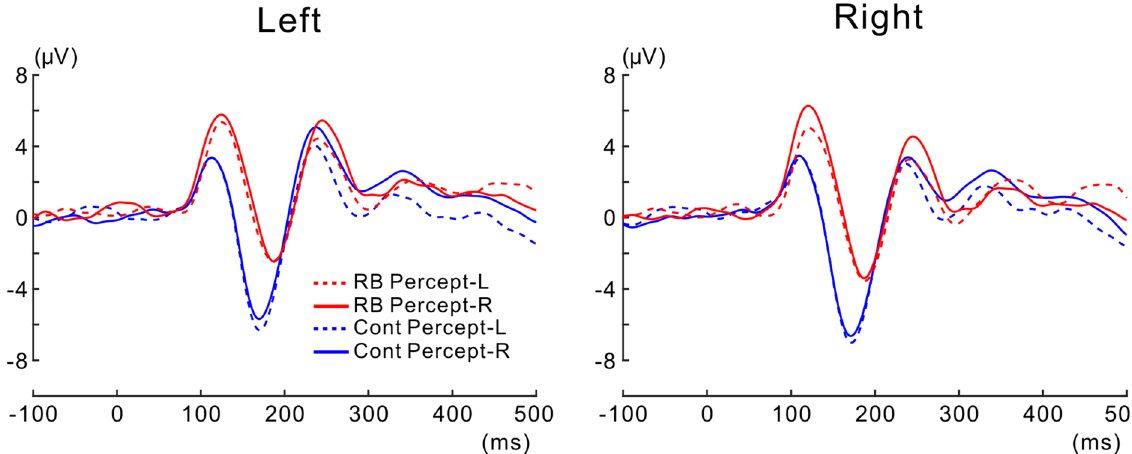
Figure 6. VEPs sorted with each percept for the Necker lattice. Grand-averaged VEPs calculated with trials where the Necker lattice was perceived as an upper-left-facing lattice (Percept-L) and those calculated with trials where the Necker lattice was perceived as a lower-right-facing lattice (Percept-R) are shown as a dotted line and continuous line, respectively. Grand-averaged VEP waveforms recorded in the RB condition are depicted in red and those recorded in the Control condition are depicted in blue. In each condition, the grand-averaged VEP for Percept-L was almost the same as that for Percept-R (see texts for